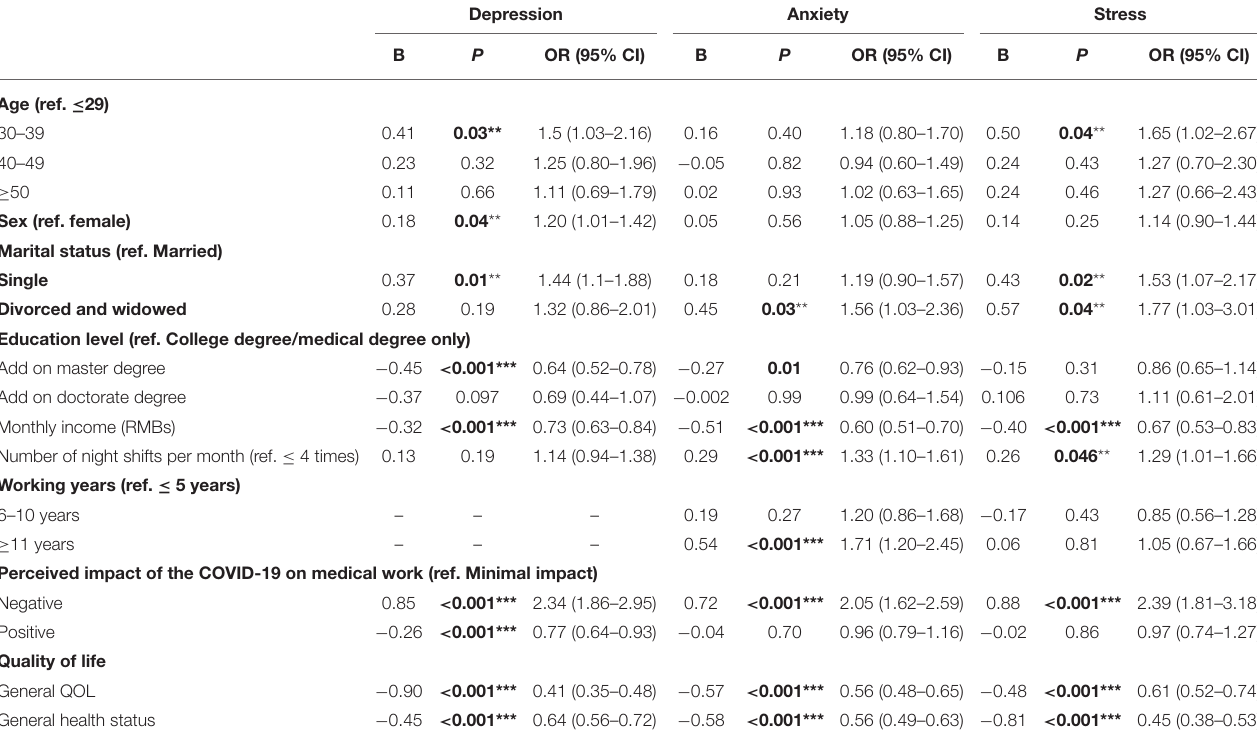
TABLE 2 | Multivariable logistic regression analysis of depressive, anxious and stress symptoms in 3,783 Psychiatrists in China. Depression Anxiety